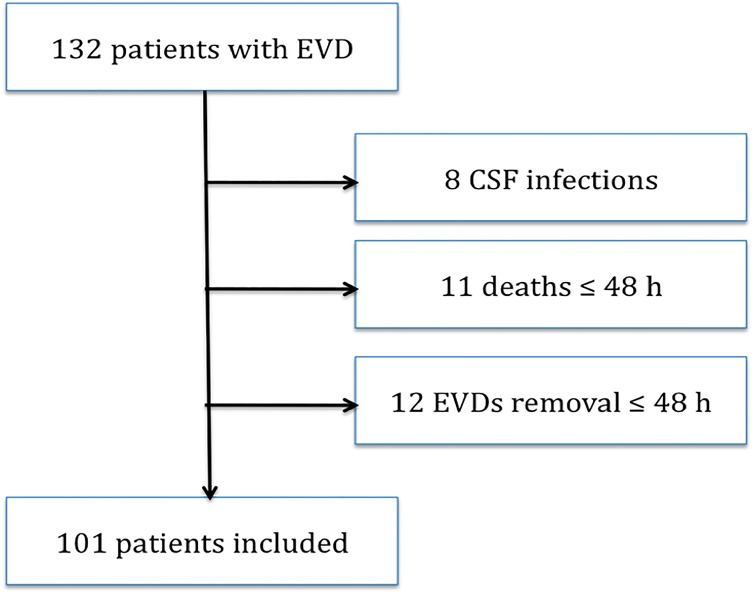
Flow Chart of the patients.132 patients older than 18 year-old received external ventricular drainage for at least 48 hours. From September 2009 to February 2011, 101 patients were included.